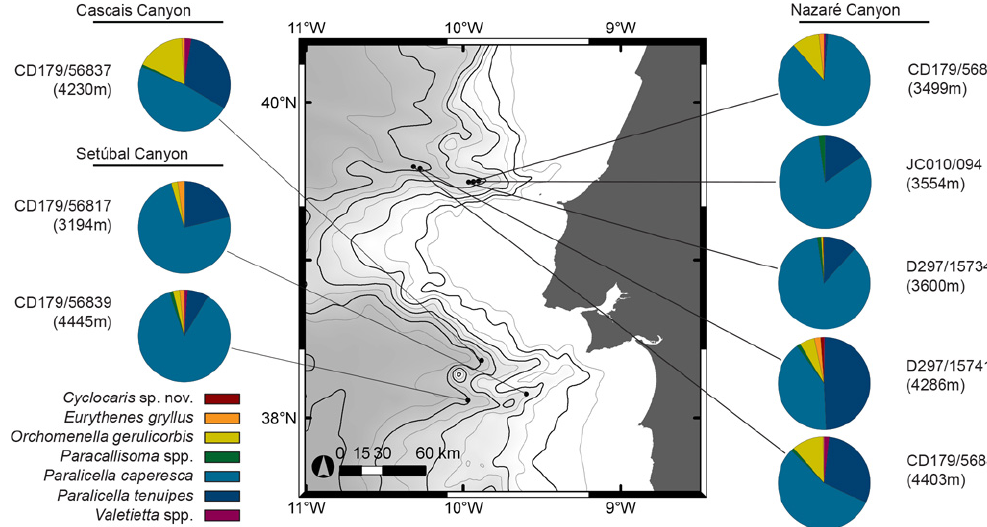
Fig. 2. Species composition of samples collected from trap deployments in submarine canyons off the Iberian Peninsula.